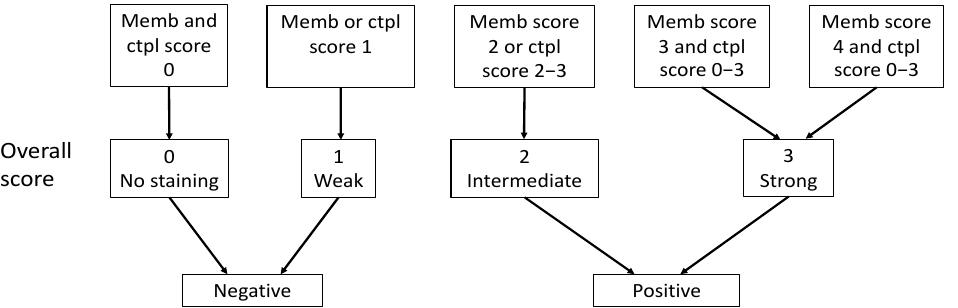
Figure 2. Classification of SSTR overall score as positive or negative based on membranous score and cytoplasmic score. Abbreviations: Memb, membranous; Ctpl, cytoplasmic.